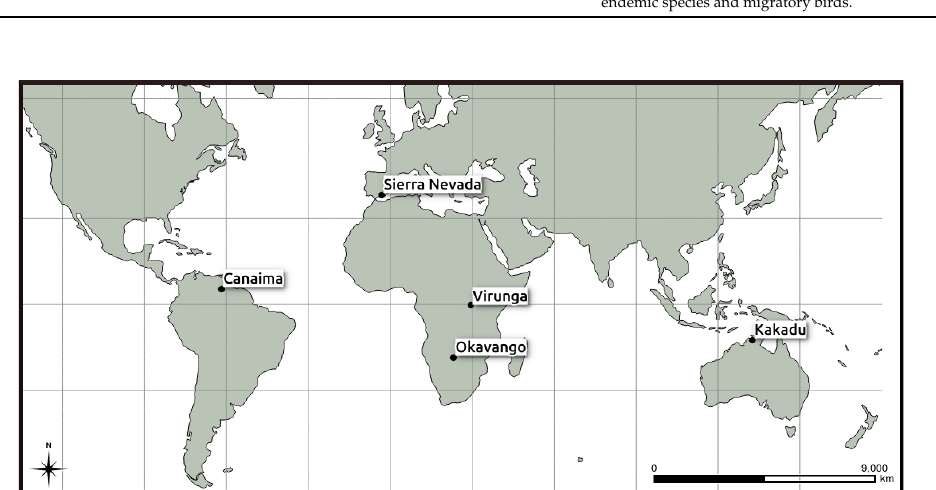
of rhinos, elephants and water birds.